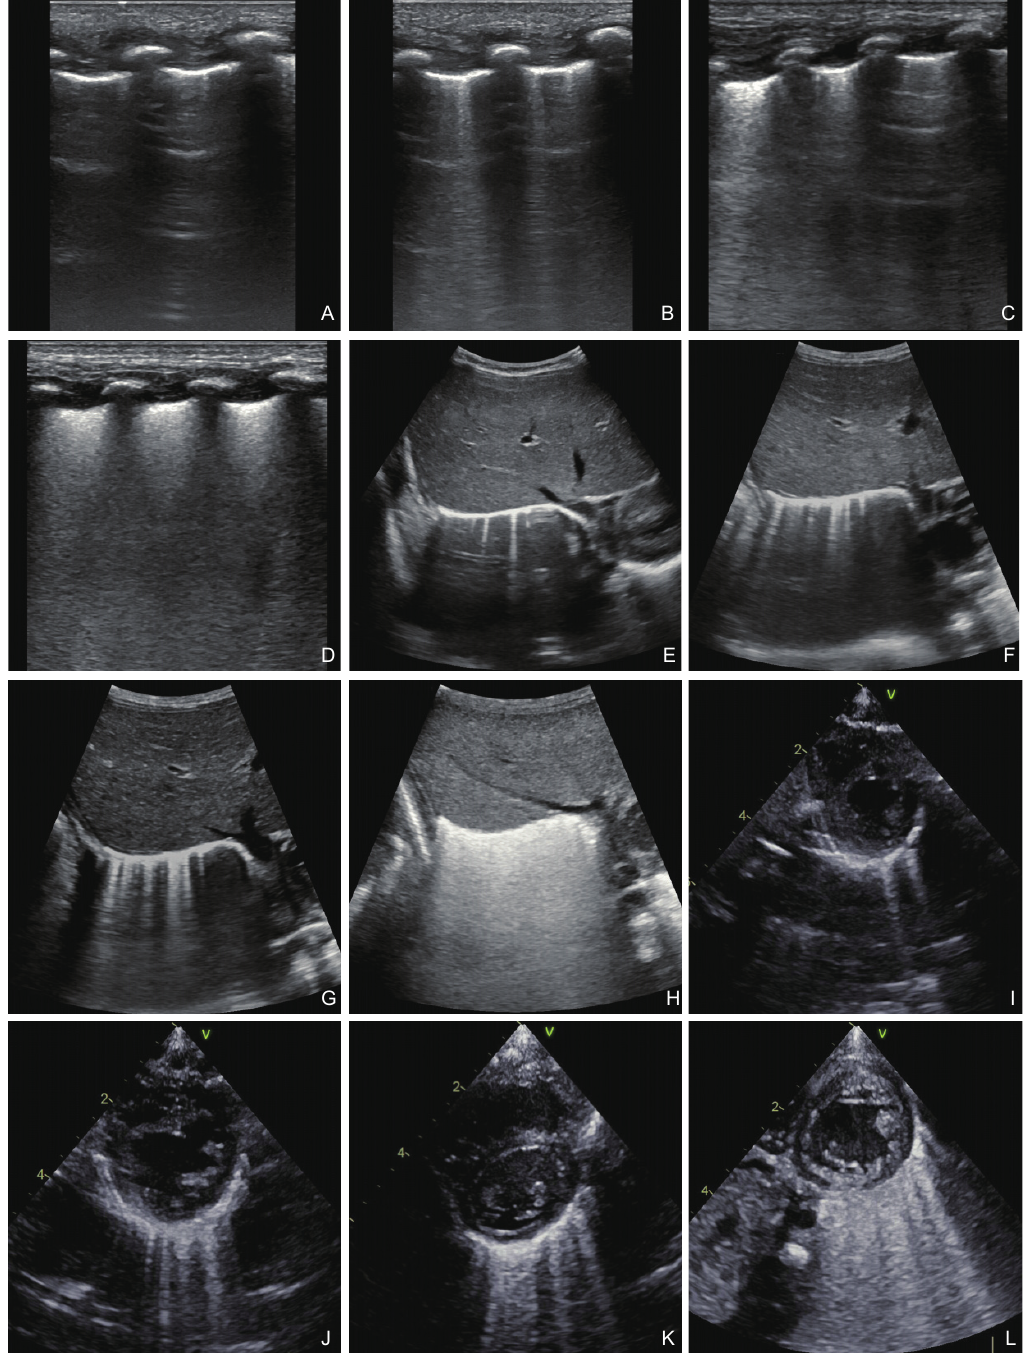
Figure 4 B-lines. (A ~ D) B-line scan of Transthoracic lung surface; (E ~ H) B-line scan of subcostal; (I ~ L) B-line scan of parasternal precordial area. Scattered B-lines, sparse B-lines, dense B-lines and fused B-lines are displayed